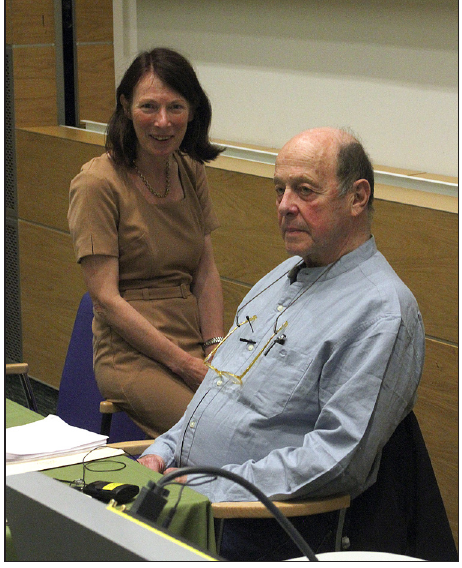
Figure 1: Professor James C Scott with